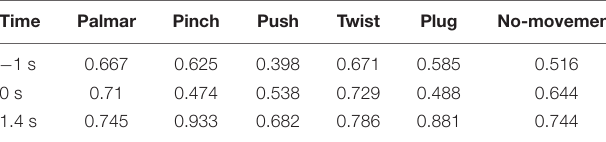
TABLE 5 | The average clustering coefficient of network for each condition of S2.